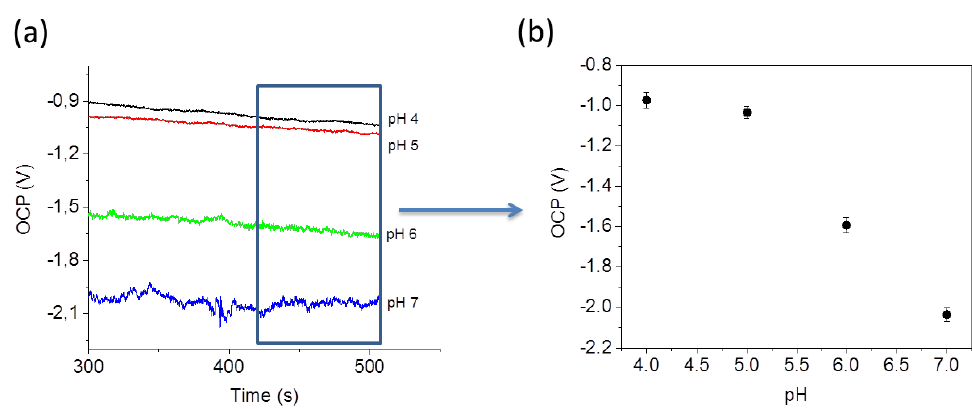
Figure 6. ( a ) Open current potential (OCP) recorded at different pH values in function of the time; ( b ) Mean values for the OCP at each pH value (error bars represent the standard deviation).